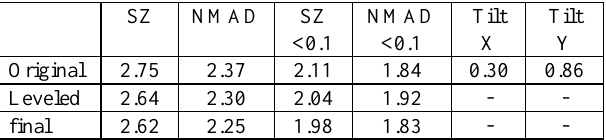
Table 14: Accuracy figures and DSM-tilt over full range [m] – Pléiades DSM against AW3D30 DSM, Zonguldak